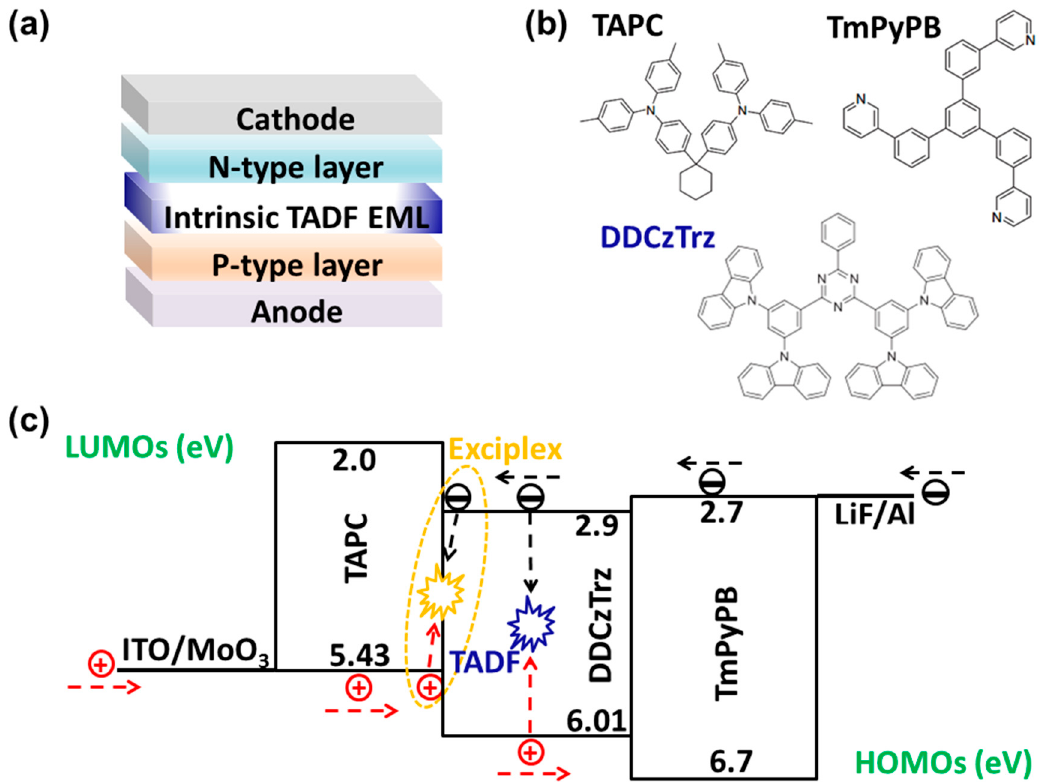
Figure 6. ( a ) The device architecture for p-i-n WOLEDs. ( b ) Molecular structures of TAPC, TmPyPB and DDCzTrz. ( c ) The working mechanism. The red arrow and black arrow are the hole and electron flow, respectively [175].